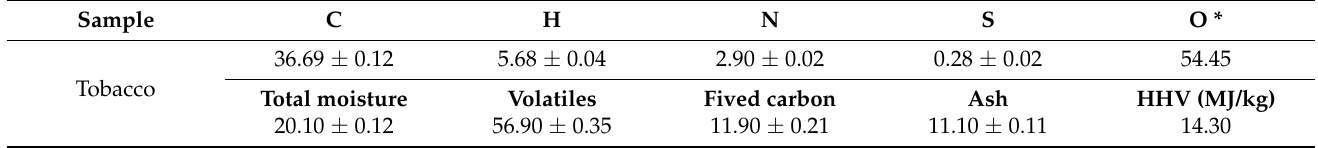
Table 1. Chemical and physical composition of the tobacco (wt.-%, dry basis). Sample